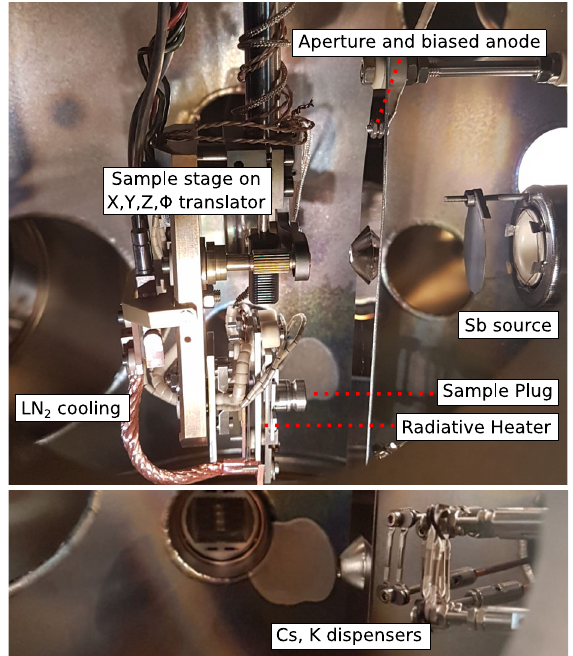
FIG. 1. Details of the geometry used for the preparation of the bi-alkali antimonide